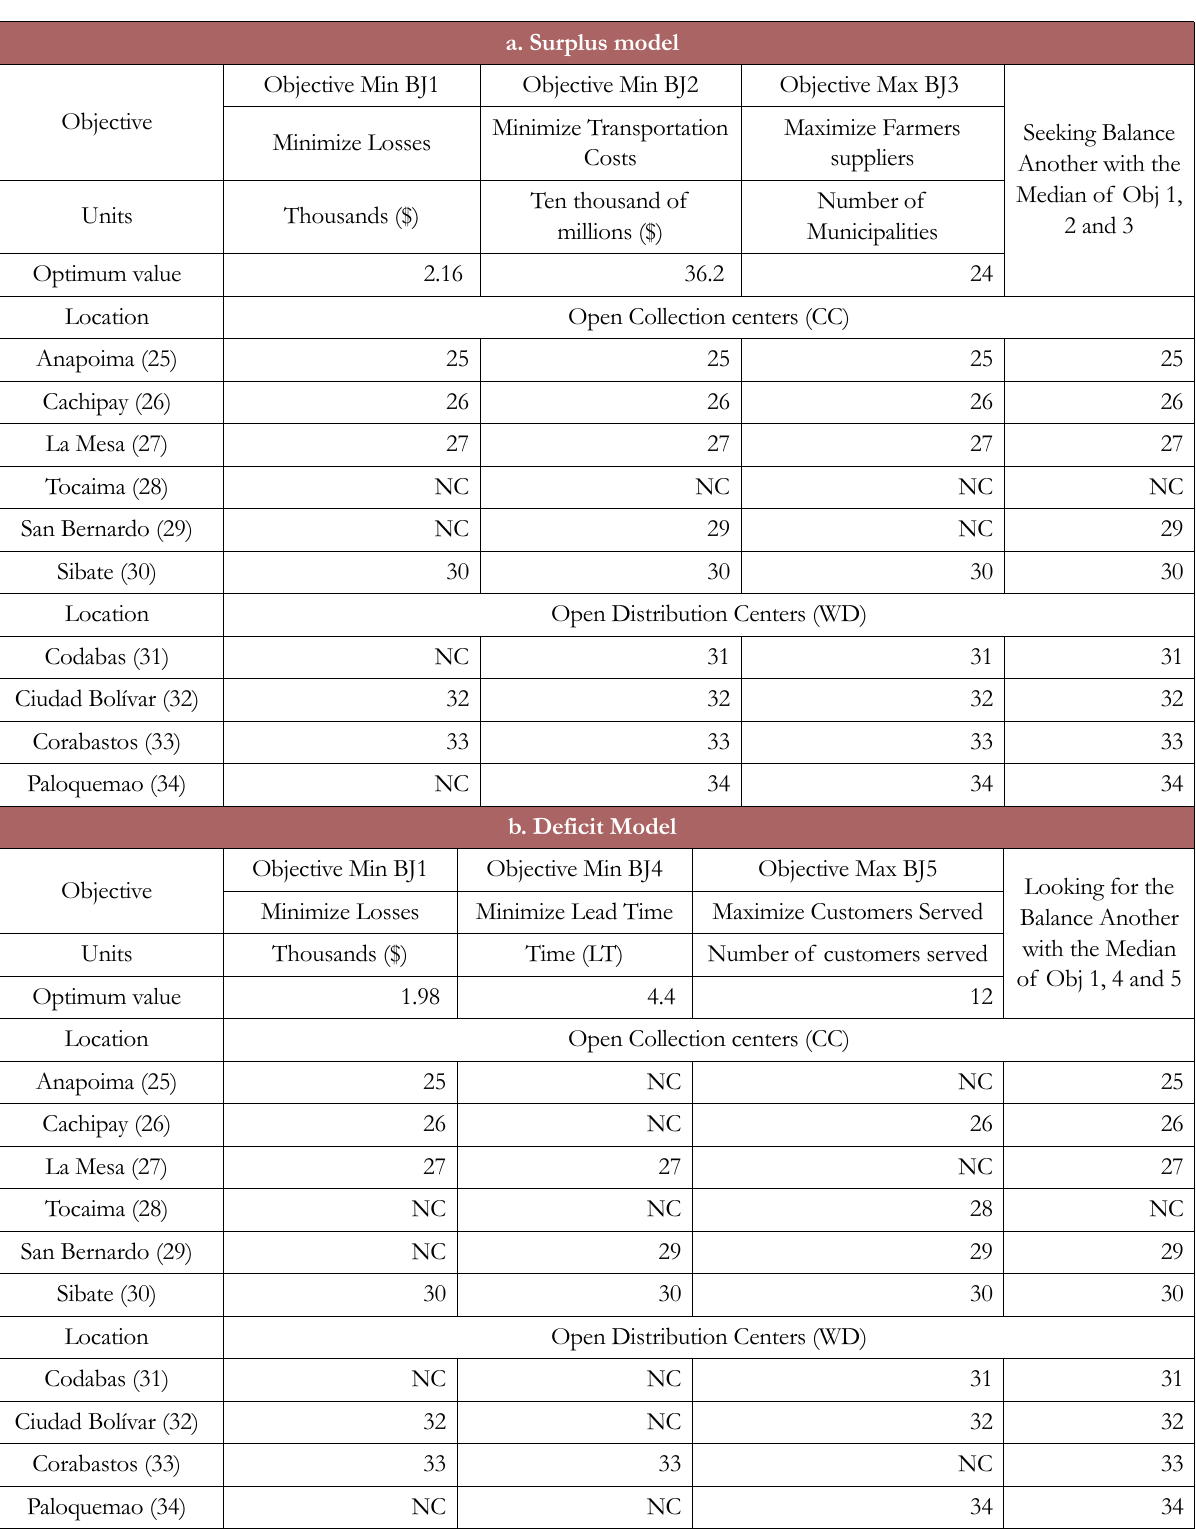
Table 1. Location of Collection Centers (Cundinamarca) and Distribution (Bogotá